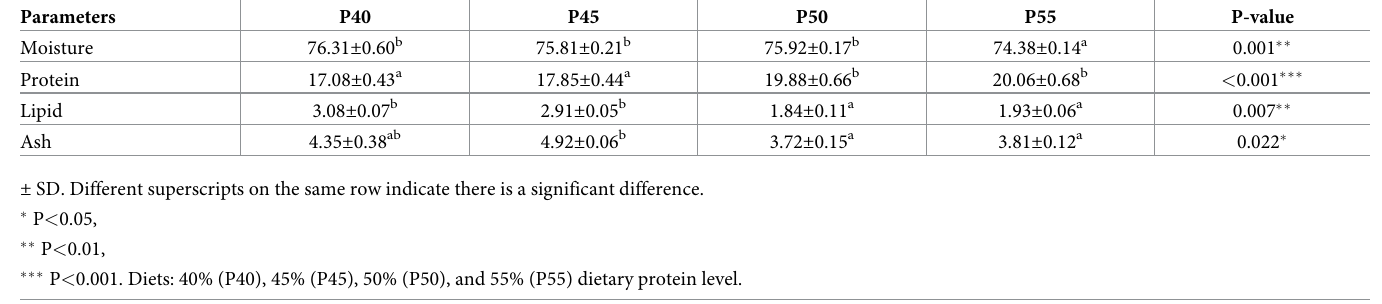
The results for the amino acid profile of bullseye snakehead fed on different levels of protein are given in Table 5. In the current study, a total of eighteen amino acids were analyzed from which sum of essential and non-essential amino acid concentration in the muscle of fish fed P55 (55%) protein was significantly higher than that of fish fed with P40, P45, or P50 protein diets. Dietary protein levels significantly affected the content of lysine, methionine, and valine (p < 0.05), while no significant changes were observed in other essential amino acids content (p > 0.05). Further- more, no significant differences was found in serine measured between the treatments (p > 0.05), while alanine, aspartic acid, cysteine, glutamic acid, glycine, proline, tyrosine, and ornithine con- tent in non-essential amino acids were significant (p < 0.05). For glutamic acid + glutamine, there was an increasing trend in measured levels as dietary protein had increased, which led to P55 Table 4. The body composition of bullseye snakehead ( Channa marulius ) fish after being fed with increasing protein levels diets for 90 days (%, wet basis, n = 3 replications). Parameters